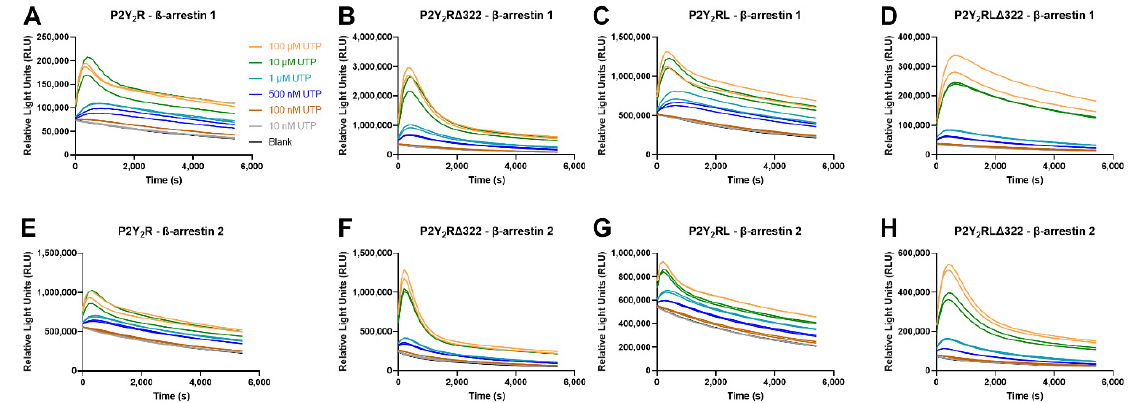
Figure 6. Time-luminescence profiles obtained in the NanoBiT ® assay by recruitment of β arr1 (panels A – D ) or β arr2 (panels E – H ) by the full length P2Y 2 R-LgBiT (panels A , E ), the C-terminally truncated P2Y 2 R ∆ 322 -LgBiT construct ( B , F ), P2Y 2 R L -LgBiT ( C , G ) or P2Y 2 R L ∆ 322 -LgBiT, induced by reference agonist UTP. Data are from one representative experiment, out of three independent experi-